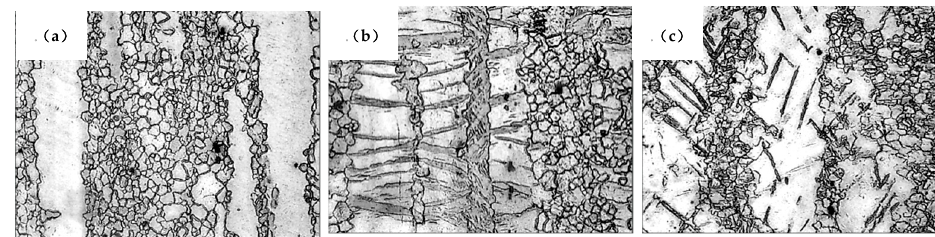
Figure 6 Predicted relative activity of different deformation modes under uniaxial compression 16 along (a) ED, (b) 45ED and (c) PED.